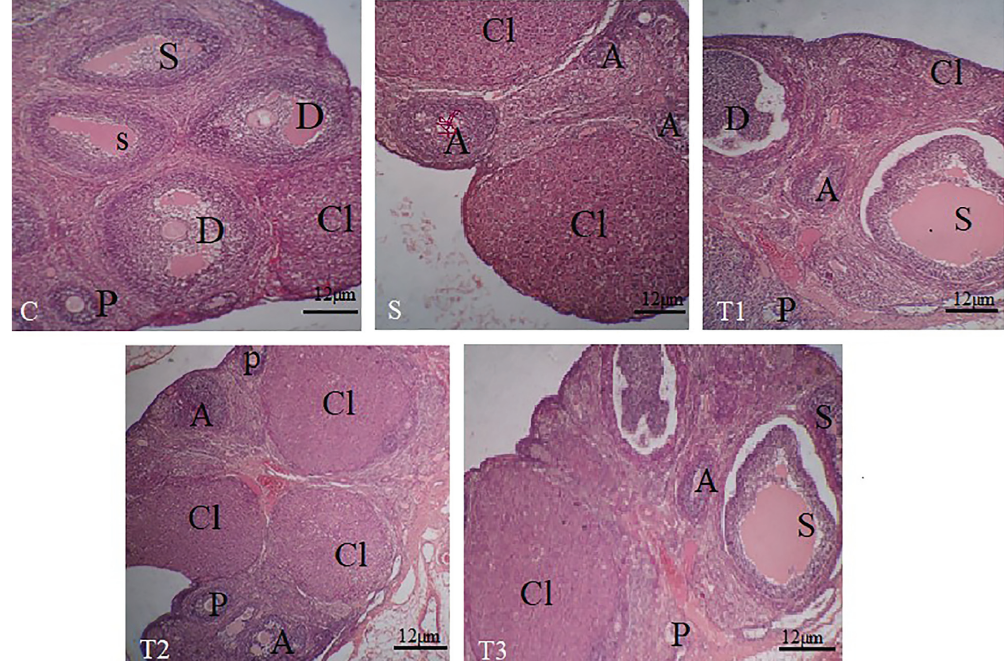
Figure 4: Ovarian microscopic sections in the studied groups. P: primary follicle; S: secondary follicle; D: graph follicle; Cl: corpus luteum; A: atretic follicle. Hematoxylin-eosin staining (magnification